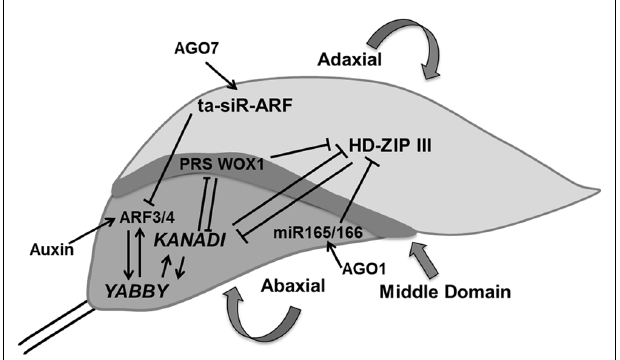
FIGURE 4 | Polarity control. The young leaf primordium has three domains which are determined by domain specific transcription factors such as HD-ZIP III, KANADI, and PRSWOX1 for adaxial, abaxial, and middle regions, respectively.These transcription factors inhibit expression of each other and thereby control their expression in another domain. AGO1 regulates miR165/66 which inhibits HD-ZIP III whereas AGO7 stabilizes ta-siR-ARF which causes the degradation of ARF3/4, which itself is controlled by auxin. YABBY determines the abaxial side in cross talk with KANADI (pointed and T shaped arrows indicate positive and negative regulation,